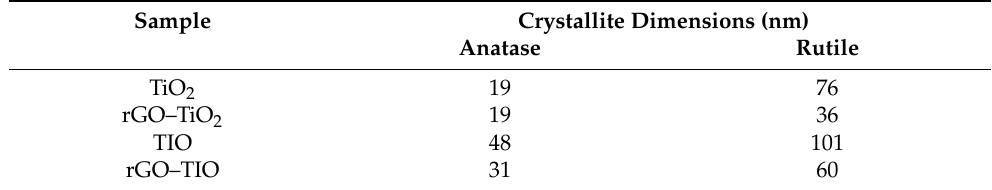
Figure 6. XRD patterns (bottom to top) of rGO, rGO–TiO 2 , and rGO–TIO membranes. In the figure, GO—graphene oxide, Gr—graphite, A—anatase, R—rutile, and C—calcite. A further confirmation of the absence of intercalation can be found by comparing TiO 2 crystallite dimensions of pure Degussa P25 and tionite powders, which are quite consistent with those of TiO 2 in the corresponding rGO-based composite membranes (Table 2). Table 2. Anatase and rutile crystallite dimensions in pristine TiO 2 and tionite, as well as in the corresponding composite membranes.